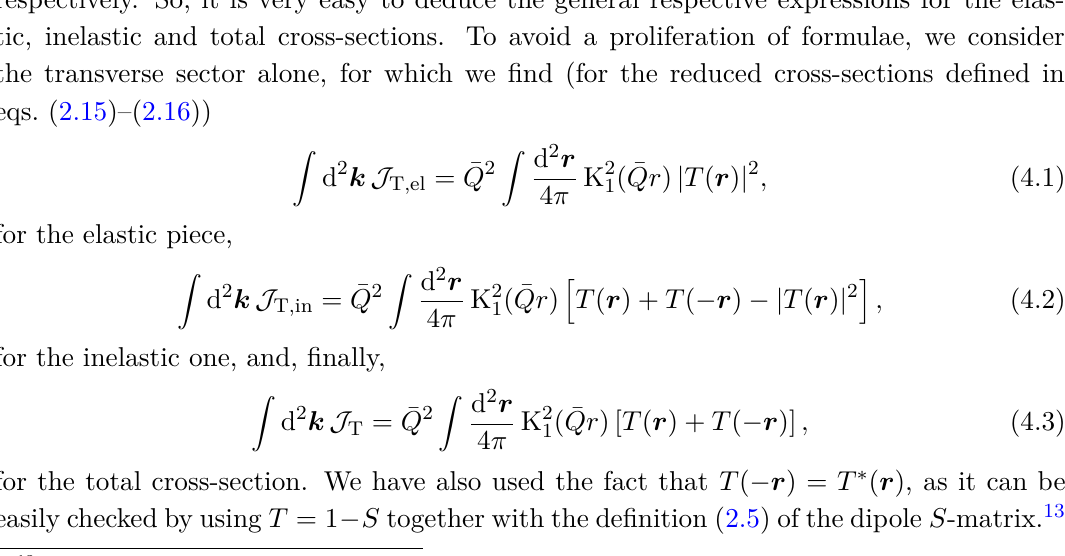
. (b)The ratio R pA defined in eq. (3.22), plotted /Q 2 s 0 ⊥